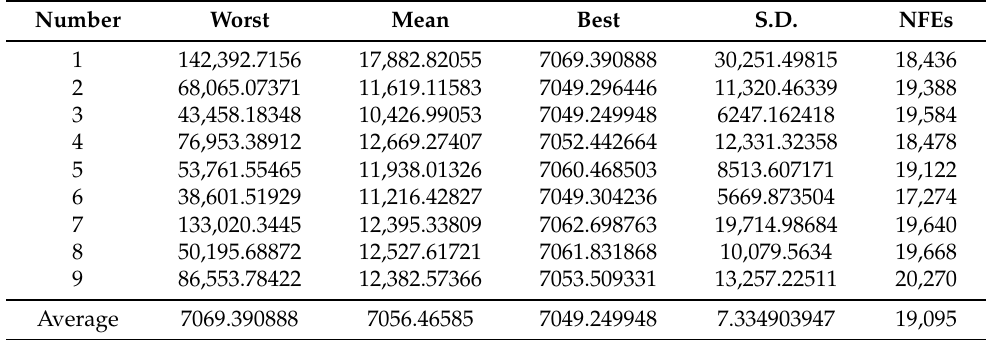
Table 10. Statistical results for G10 by MAM.